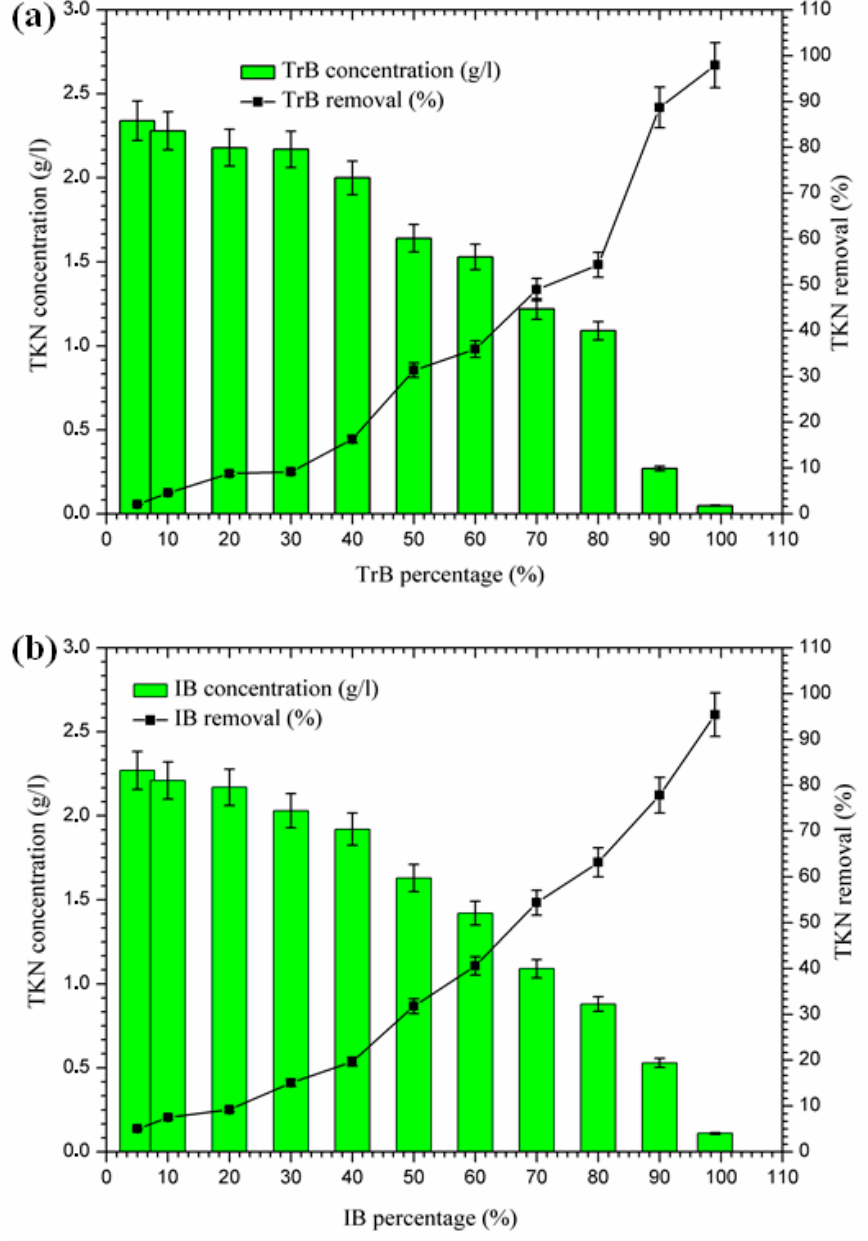
Figure 7. ( a ) Concentration and removal percentage of TKN by TrB; ( b ) concentration and removal percentage of TKN by IB.